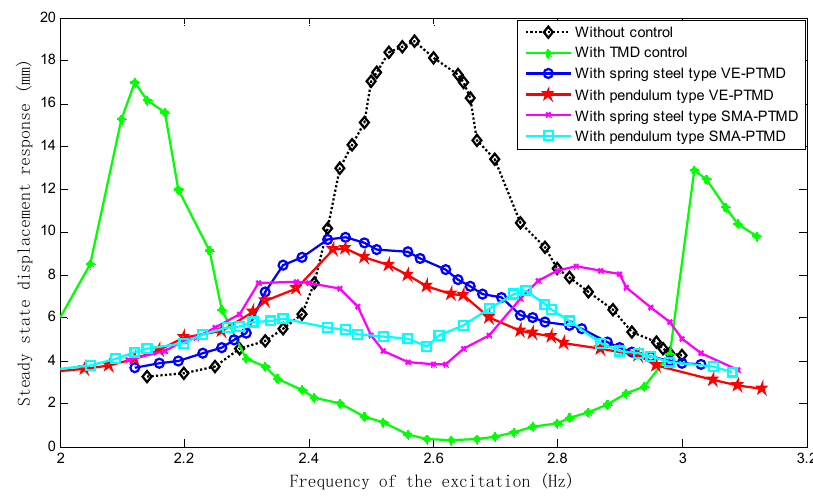
Figure 8. Experimental results of forced vibration.